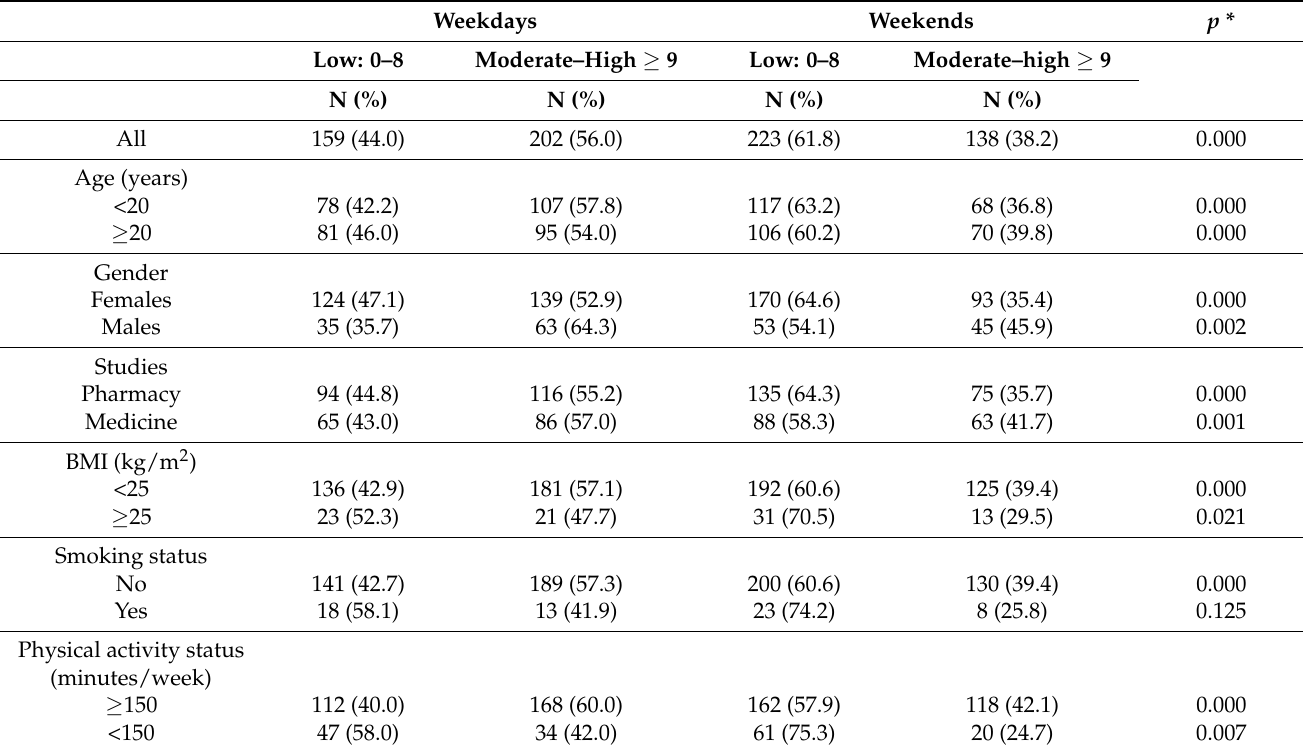
Table 5. Levels of the AMD index